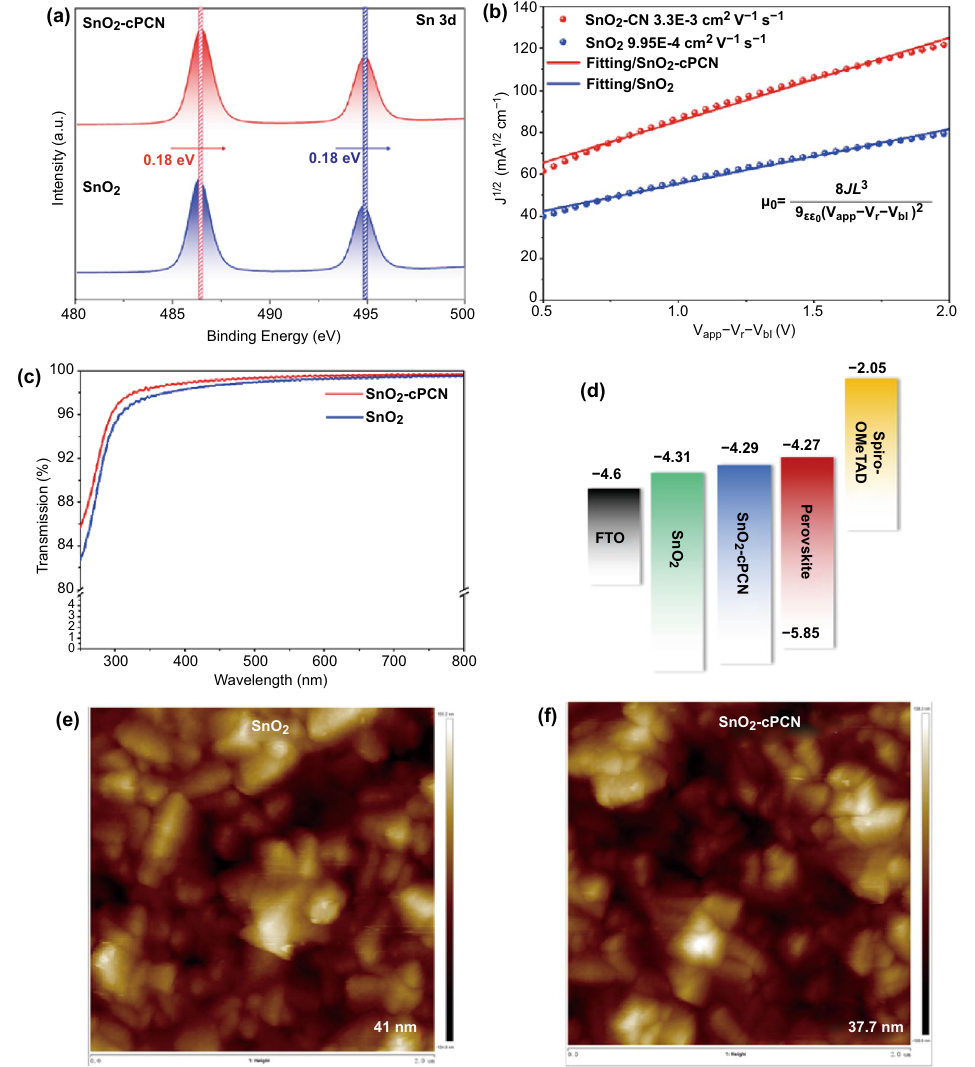
Fig. 2 Characterization of SnO 2 and SnO 2 -cPCN ETLs. a XPS spectra of films deposited on quartz substrates. b Electron mobility calculation using the SCLC model with the device structure of FTO/ETL/PCBM/Ag. c Optical transmission spectra on quartz substrates. d Possible band alignment of the ETLs and perovskite layer according to the UPS measurements. e , f AFM topographical images of SnO 2 , and SnO 2 -cPCN